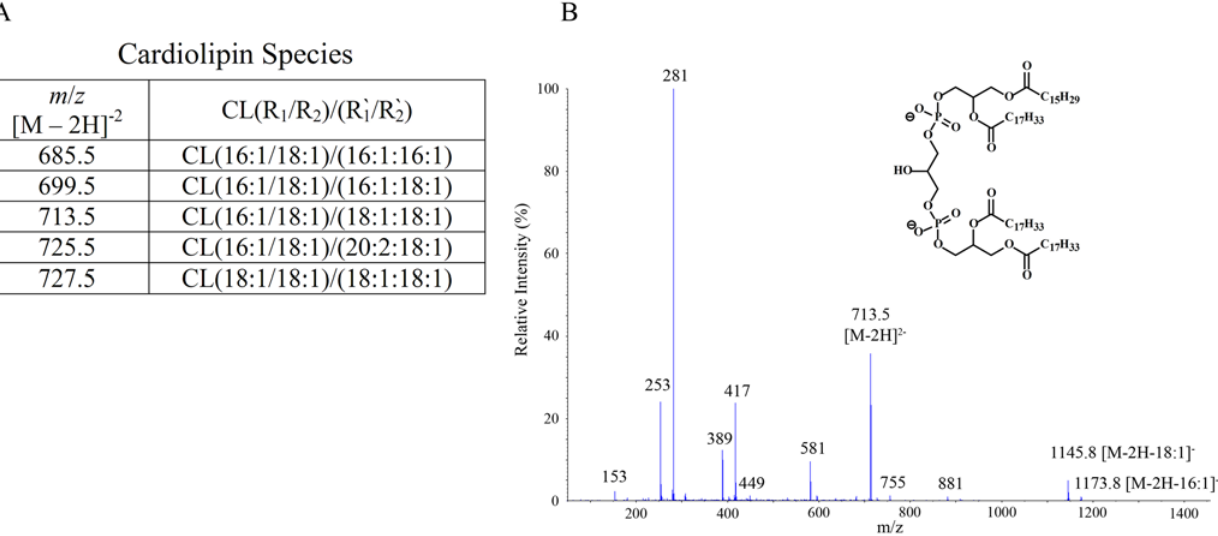
Figure 5. Identification of cardiolipins. Cardiolipins, which are tetraradyl dimers of phosphatidylglycerol, were present in the CD1d ligand pool. A ) Table summarizing the cardiolipin species identified. B ) Negative ion MS/MS of ion m / z 713.5 from the MS ion map of Fraction 18, containing cardiolipin (18:1/16:1)/(18:1/18:1). The map shows m/z 713.5 [M 2 2H] 2 2 , m/z 1173.8 [M 2 2H 2 C 15 H 29 CO 2 ] 2 , m/z 1145.8 [M 2 2H 2 C 17 H 33 CO 2 ] 2 , m/z 581 [(713.5 6 2 2